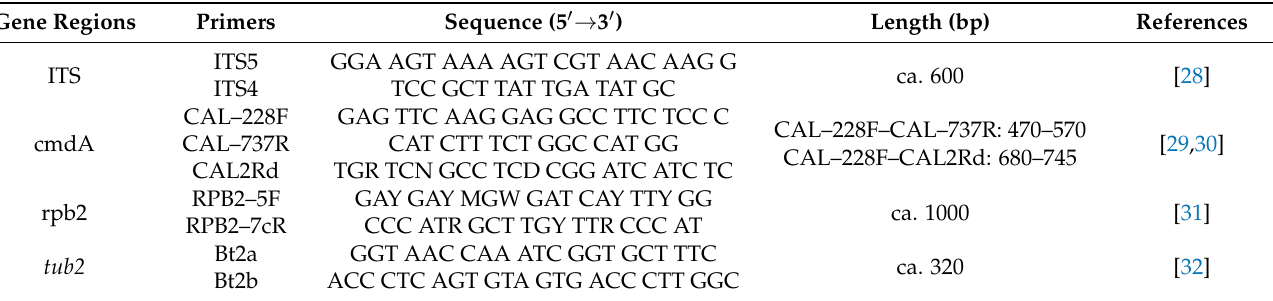
Table 3. Gene regions and primer sequences used in this